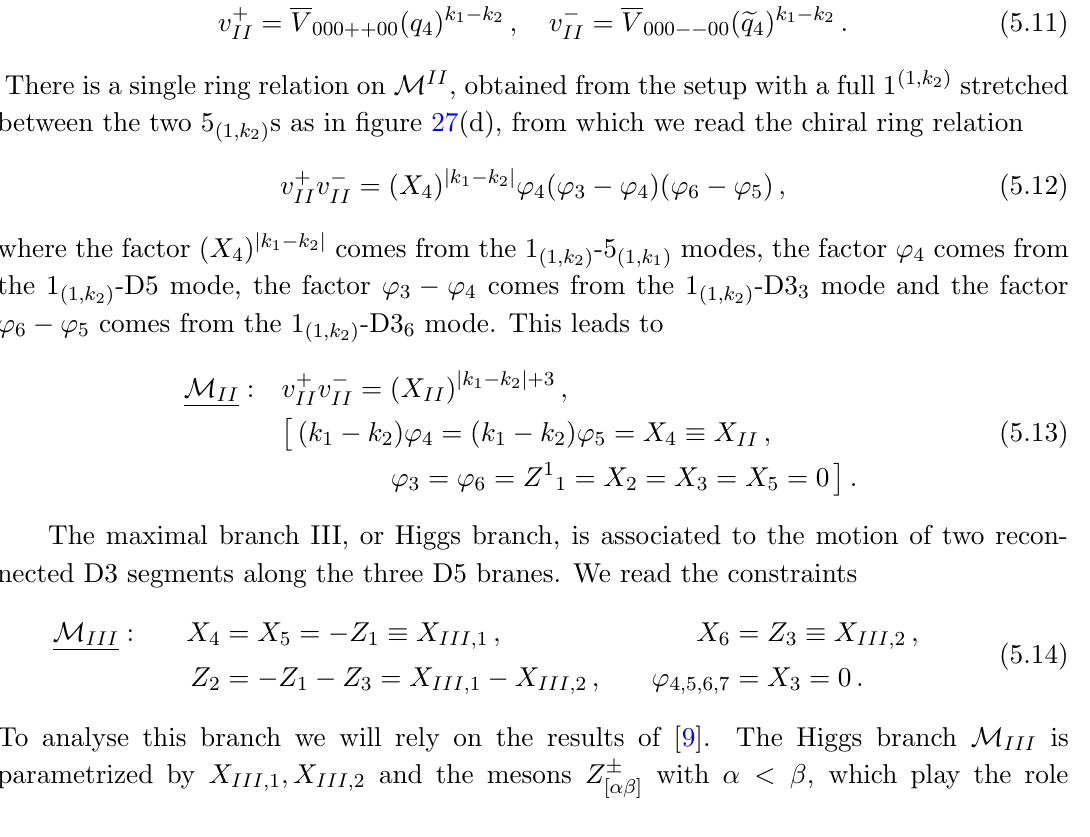
v (cid:0) = ( X II ) j k 1 (cid:0) k 2 j +3 . Only the relevant part of the brane setup is II II branes in the x 47 (1 ;k 2 )